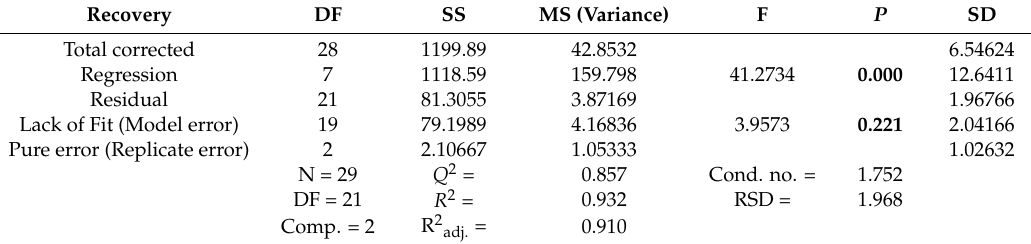
Table 2. Analysis of variance (ANOVA).